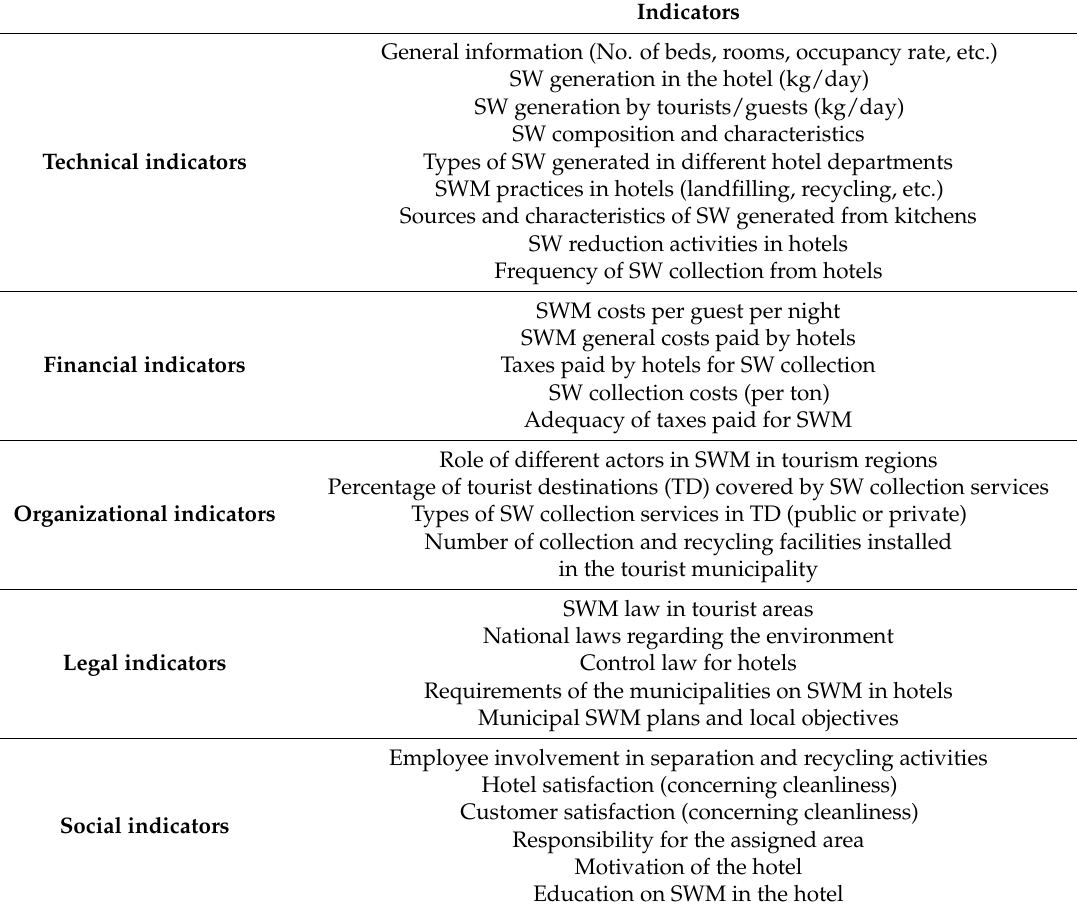
Table 1. Key indicators classification for solid waste management (SWM) in tourist